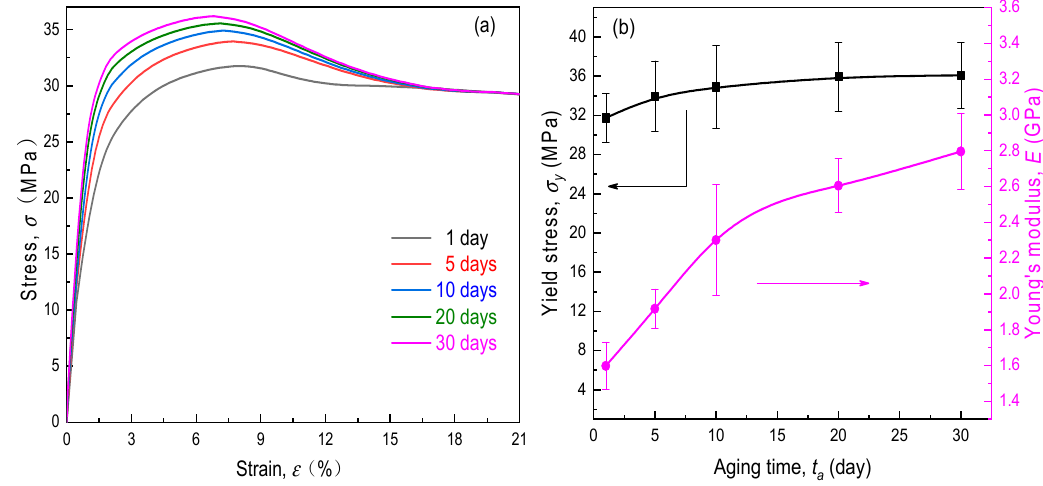
Figure 4. Effect of aging time on the ( a ) stress–strain curves and ( b ) tensile properties of solid polymer electrolyte (SPE) films.